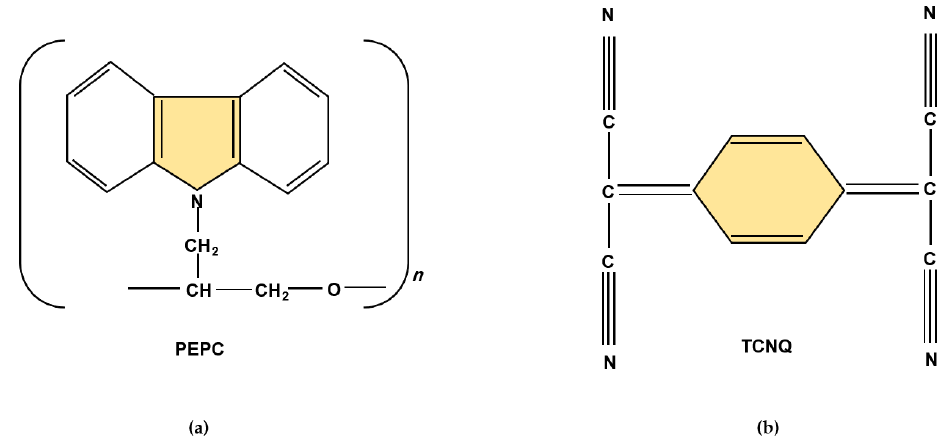
Figure 1. Molecular structure of ( a ) poly-N-epoxy-propylcarbazole (PEPC); and ( b ) 7,7,8,8-tetra- cyanoquino-dimethane (TCNQ).